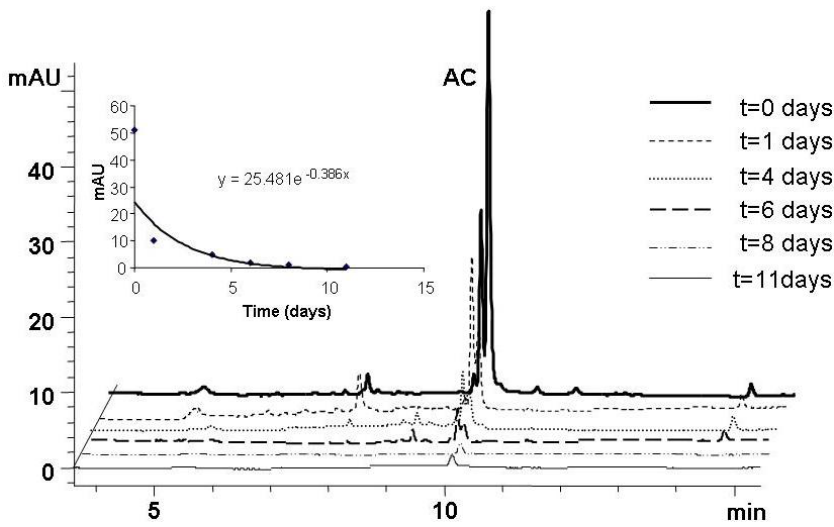
FIGURE 1. Kinetic degradation of the carminic acid in the cochineal extract for treatment 8, with Tv CDBB-H-1051. AC = carminic acid. Top left-hand side shows the degradation data (mAU), as a function of time following first-order